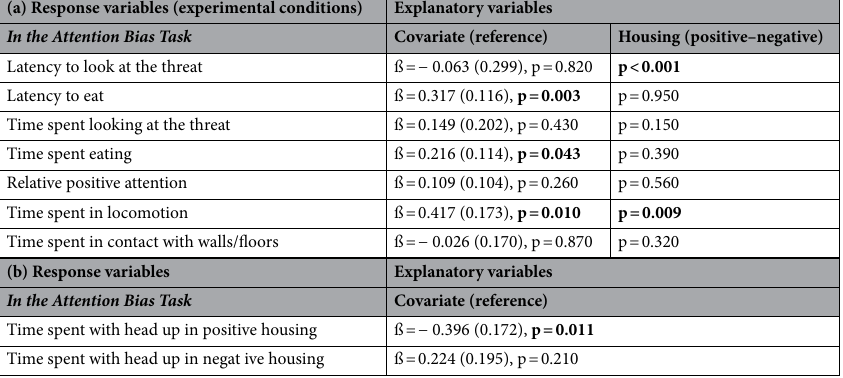
(a) Response variables (experimental